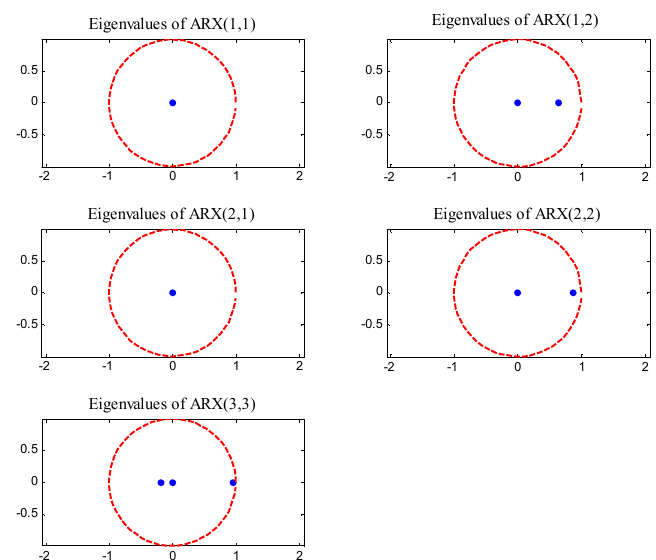
Figure 15. The root distribution of the MA part of five ARX